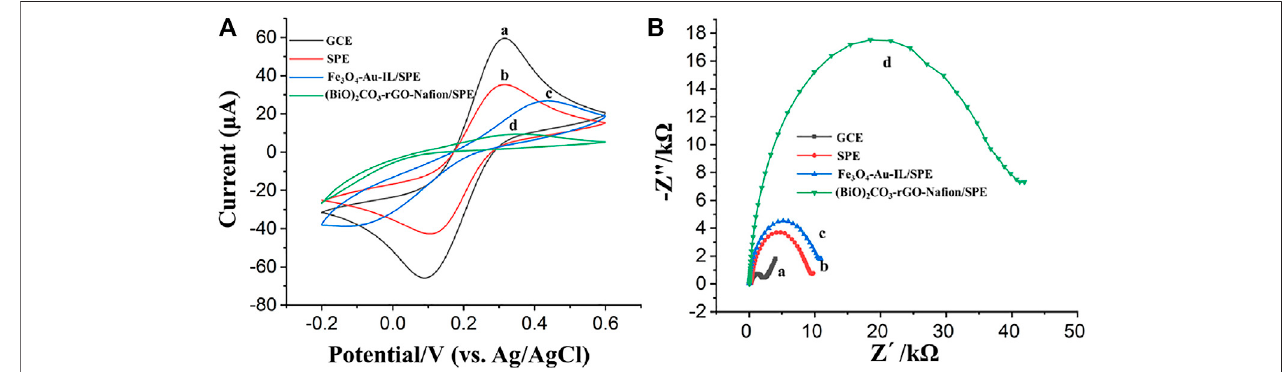
FIGURE 5 | (A) Cyclic voltammograms of (a) GCE, (b) SPE, (c) Fe 3 O 4 -Au-IL/SPE, and (d) (BiO) 2 CO 3 -rGO-Na fi on/SPE. (B) Electrochemical impedance spectroscopy (EIS)of(a)GCE,(b)SPE,(c)Fe 3 O 4 -Au-IL/SPE, and(d)(BiO) 2 CO 3 -rGO-Na fi on/SPE.CVandEIS wereperformedwithathree-electrodesystemconsistsof an Ag/AgCl reference electrode, a Pt wire counter electrode and a working electrode, i.e., GCE or the working electrode of SPE. The diameter of both the working electrodes was 3